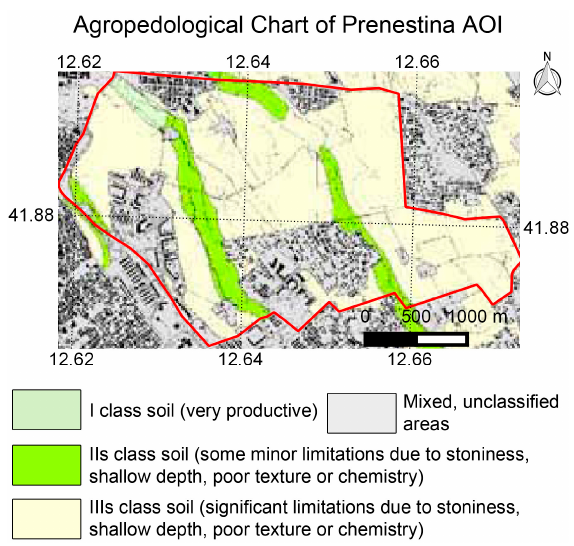
Figure 25. Land use map of Prenestina AOI (shown in red polygon), last updated in 2007. Copyright: Comune di Roma [64].